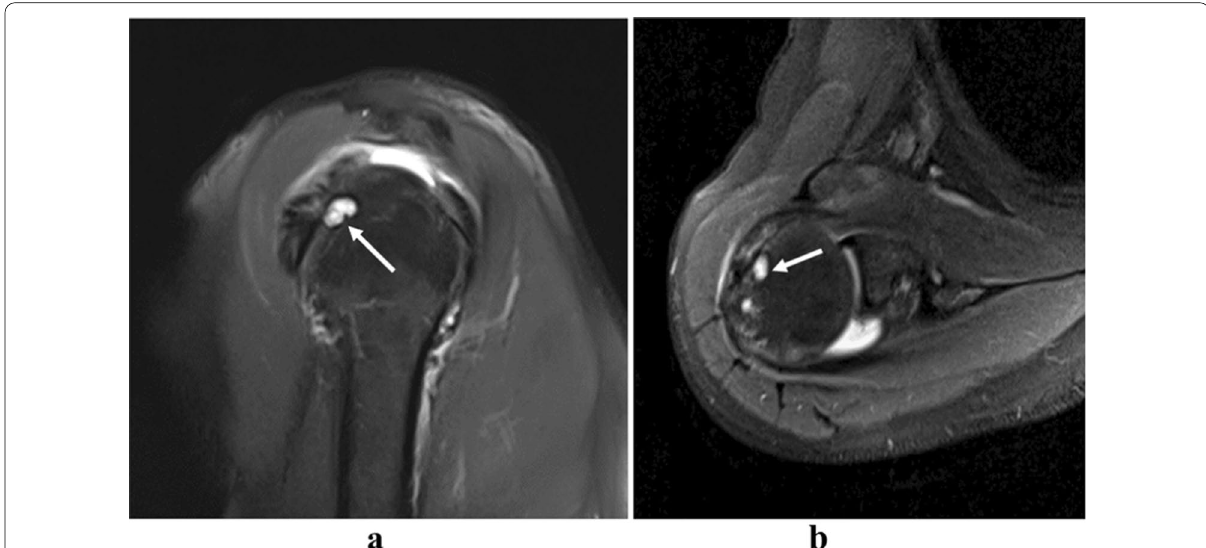
Fig. 5 Lesser tuberosity cysts (LTC) on oblique sagittal ( a ) and axial ( b ) IM-WI MRI show well-defined fluid-like cystic lesion within the lesser tuberosity (white